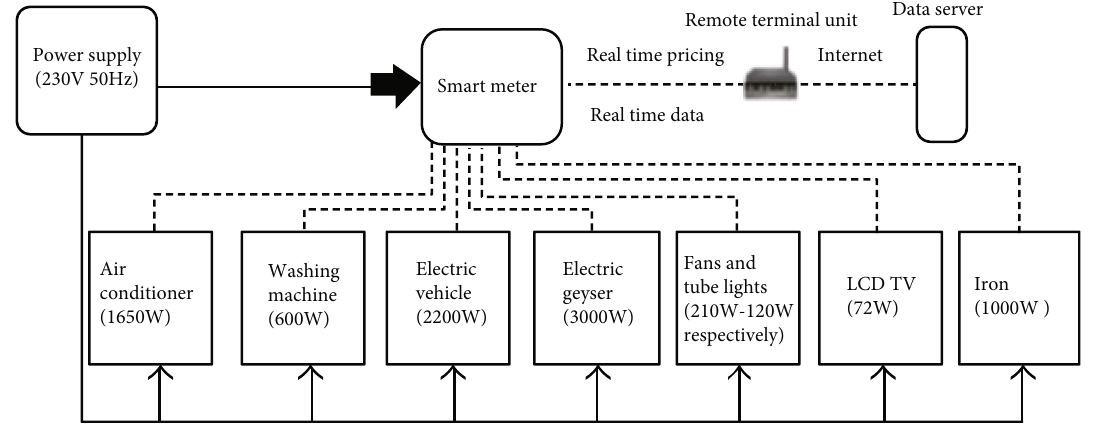
Figure 7: Block diagram of home area network